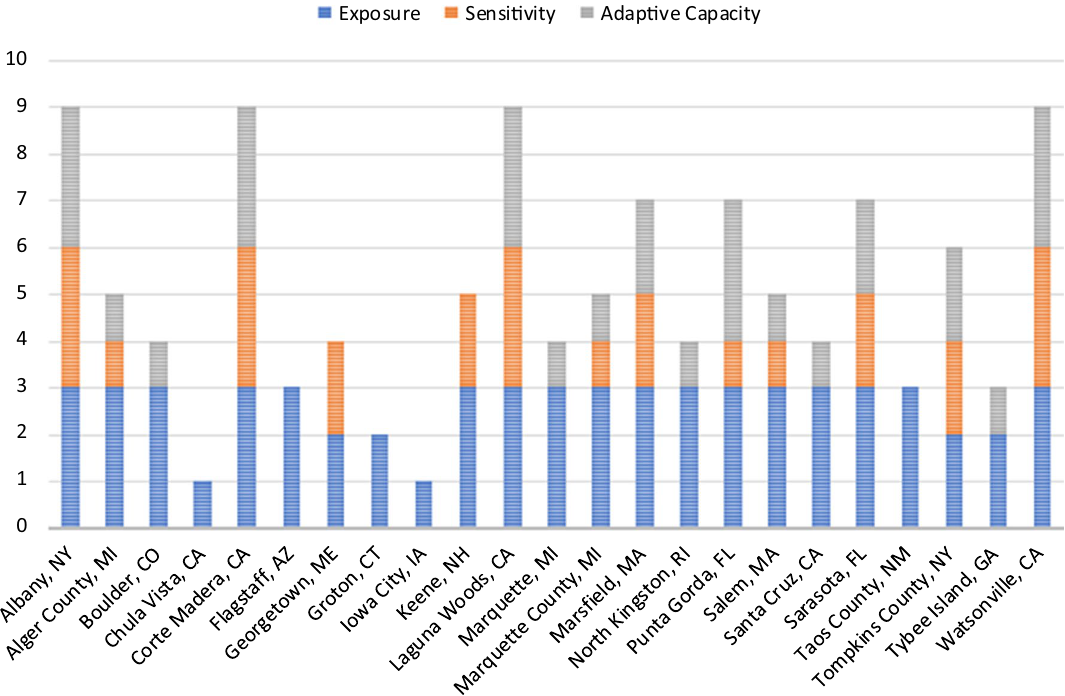
Fig. 2 Assessment of exposure, sensitivity, and adaptive capacity considered in the local